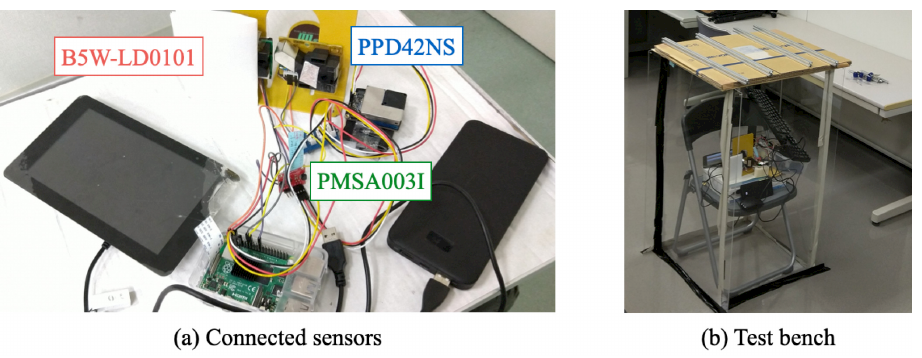
Figure 10. Sensor comparison experiment.